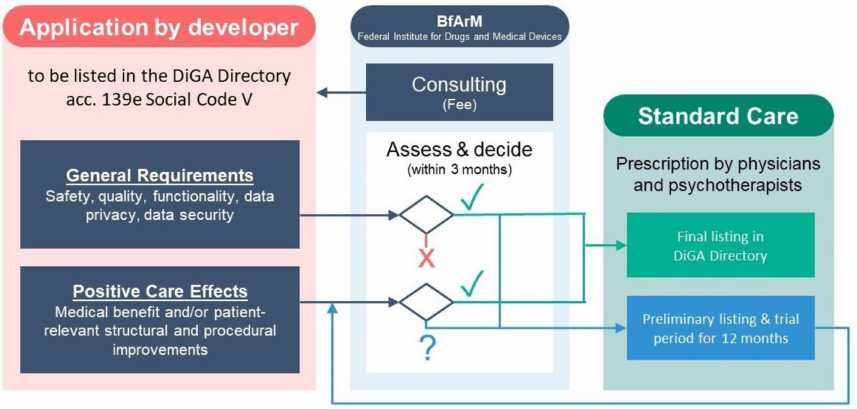
Figure 4. Fast track procedure for digital health applications in